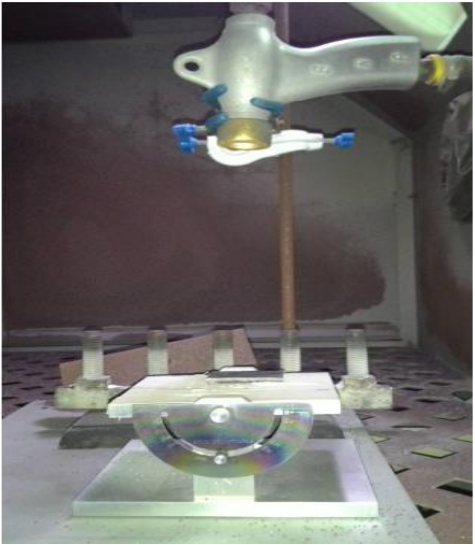
Figure 3: Test facility for sand blasting on wind turbine blade